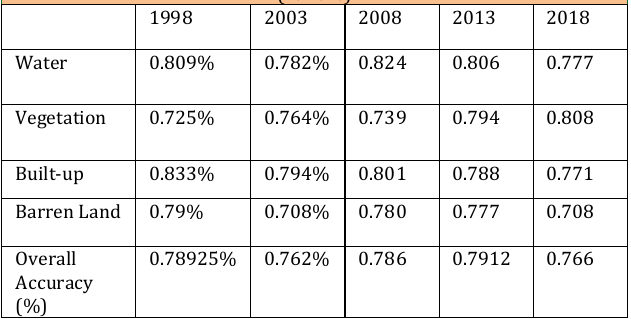
Table 2: Accuracy assessment of land use classes from 1998-2018 (Lahore)